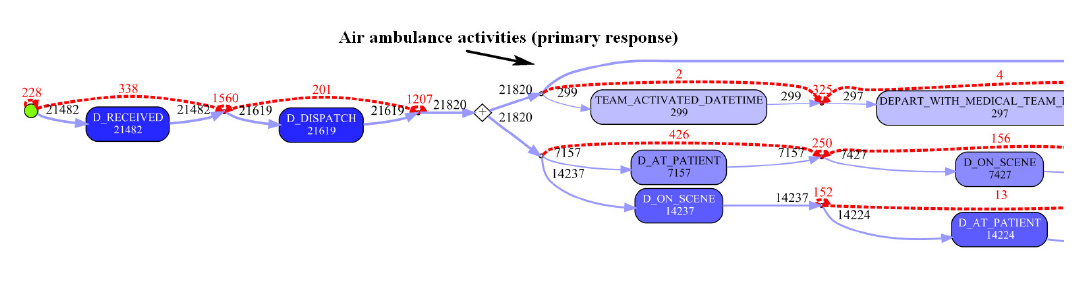
Figure 9. Edited process map fragment (Cohort 3)—air ambulance primary